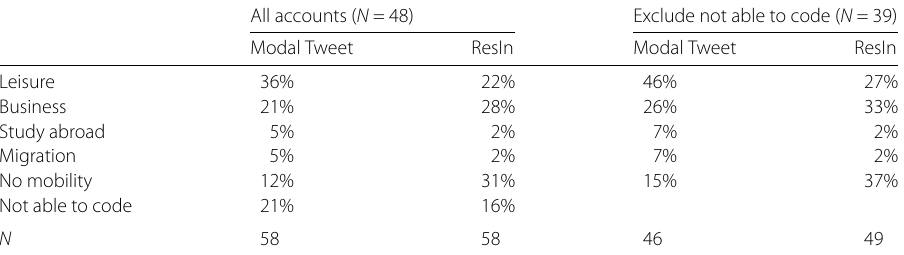
Table 2 Detailed coding of type of mobility for 48 accounts identified as migrants by Modal Tweet and ResIn